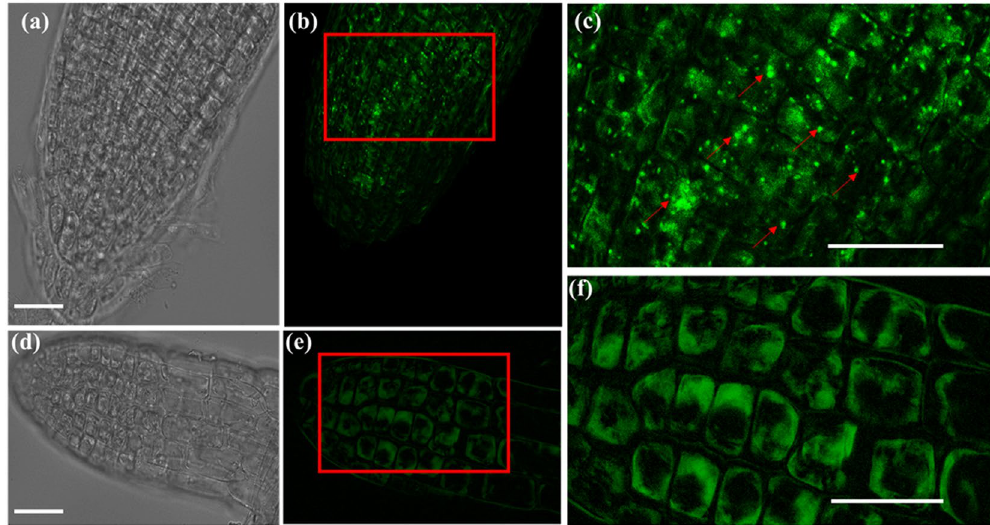
Figure 5. Salt stress Monodansylcadaverine (MDC)-labeled endosomes are induced in the primary root. Seven day old Arabidopsis seedlings were subjected to 200 mM NaCl for 24 hours. Roots were stained with MDC then analyzed by EVOS M5000 fluorescence microscopy using DAPI-specific LED cube. ( b ) MDC stained endosomes were observed in the PR ( e ), but not in the LR which lacked any bright punctate structures ( f ). ( a ) and ( d ) are the bright field image of PR and LR. ( c ) is the enlarged section of PR. In ( e ), the presence of MDC punctate structures are marked by red arrows. ( f ) is the enlarged image of LR, which lacked any bright punctate structures. Scale = 20 µ m. Fluorescent images of MDC staining in the PR and LR of non-stressed plants is provided in Fig.